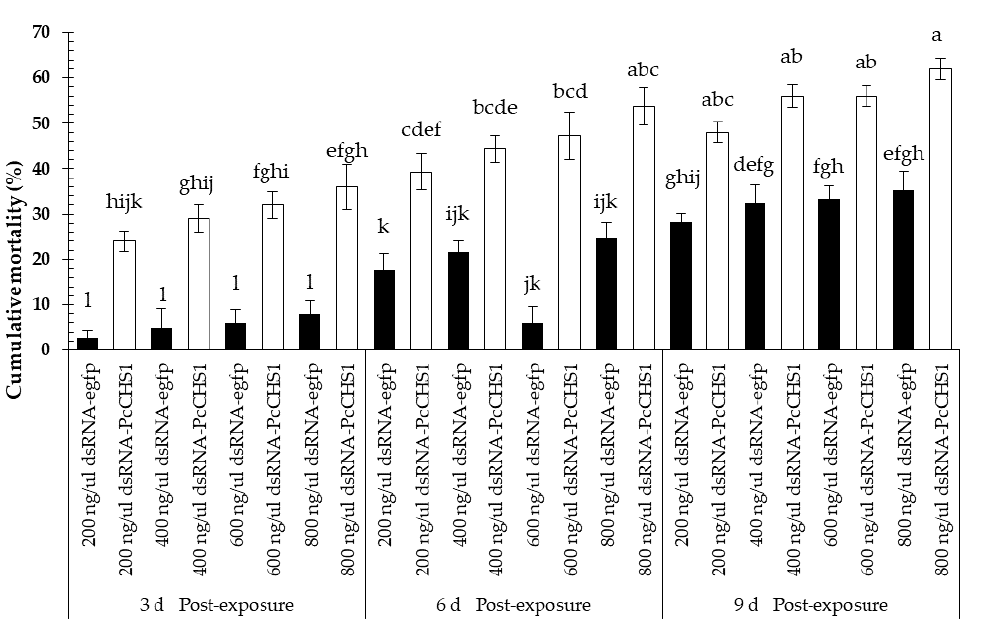
Figure 4. Time–mortality response of P. citri protonymphs upon exposure to the target gene ( PcCHS1 ) dsRNA- PcCHS1 , compared to the control group (dsRNA- egfp ). The values are the means of three independent replicates ( n = 50 per replicate). The mortality response over time was analyzed by a repeated measures ANOVA, and significant di ff erences among the means were analyzed by a Fisher’s LSD test ( α = 0.05). Di ff erent small case letters on the bars showing significant di ff erence between the